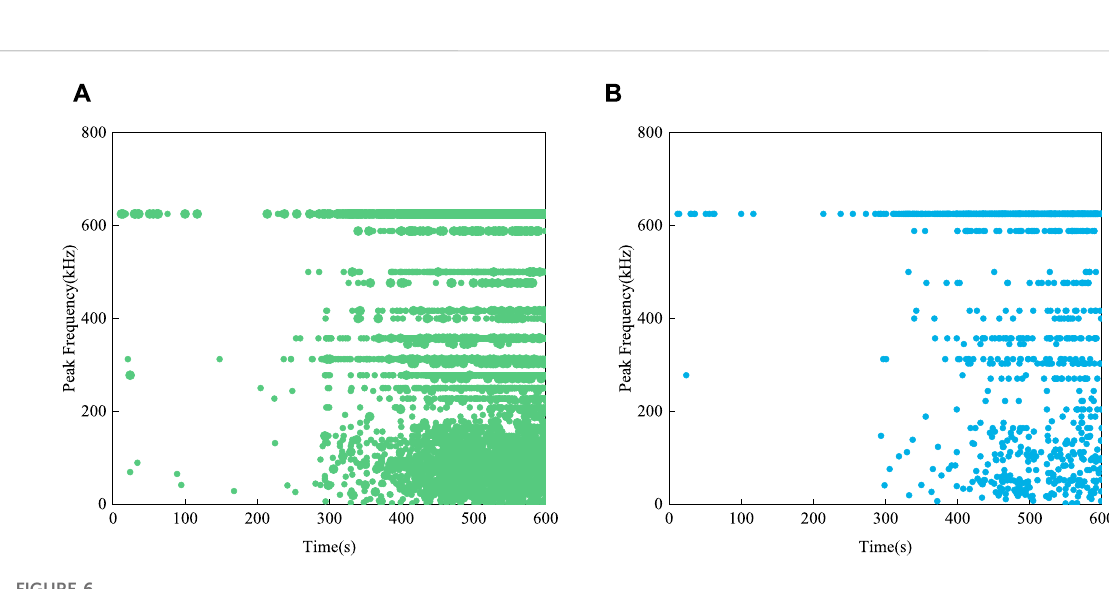
Frontiers in Environmental